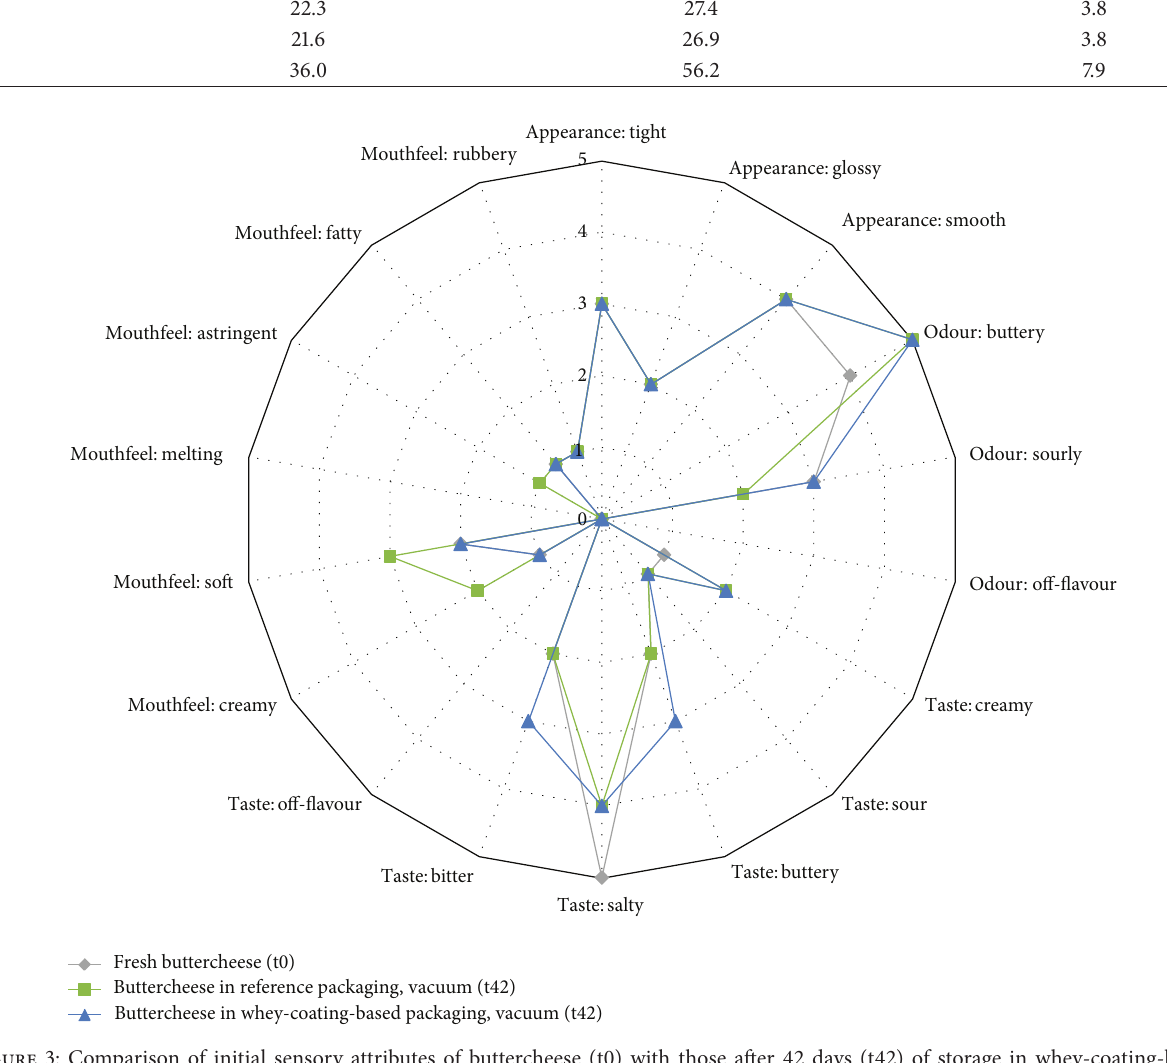
Figure 3: Comparison of initial sensory attributes of buttercheese (t0) with those after 42 days (t42) of storage in whey-coating-based packaging versus reference packaging, both packed under